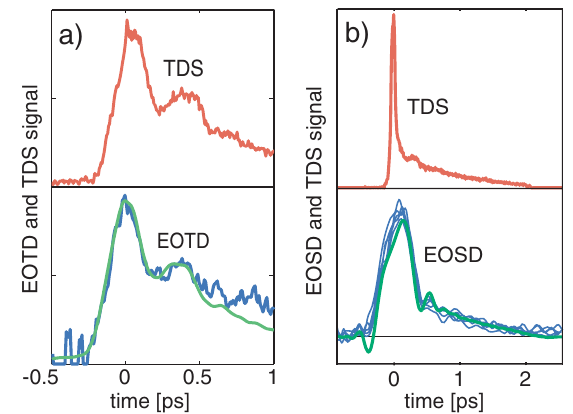
FIG. 15. (Color) Longitudinal bunch charge profiles measured with the transverse-deflecting structure (TDS), compared to the bunch electric field profiles obtained by (a) single-shot electro- optic temporal decoding (EOTD) using 65 (cid:1) m GaP with the compression system detuned (showing a double-peak structure), and (b) electro-optic spectral decoding (EOSD) using 175 (cid:1) m GaP and a fully compressed electron bunch. The bunch head is at the left side. The simulated EO signals (green) have been calculated from the TDS signals. See text for more details.